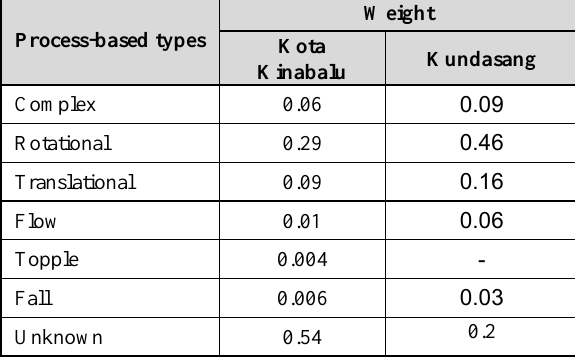
Table 4. Weight value for each landslide type for Kota Kinabalu